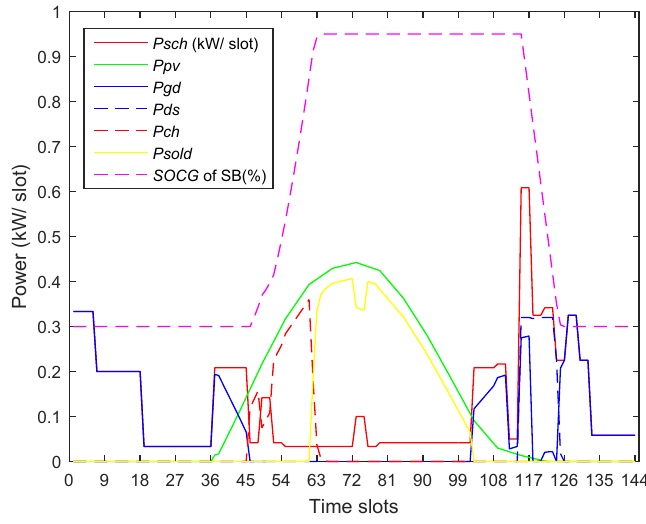
Figure 24. Load profile for minimal TBD using CPP (Non-shifted) for PDDR-RED-based HEMS.